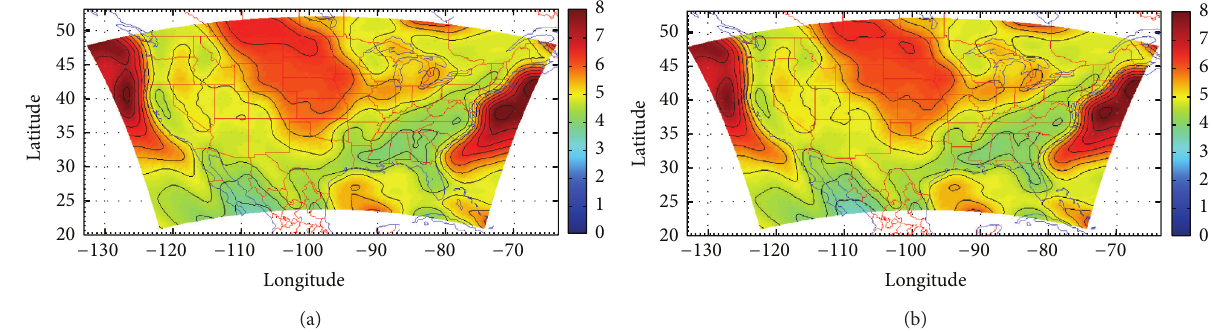
Figure 4: Average annual wind speed (ms −1 ) from CCSM3 data for (a) 2040s and (b) 2090s under the A1B climate scenario.